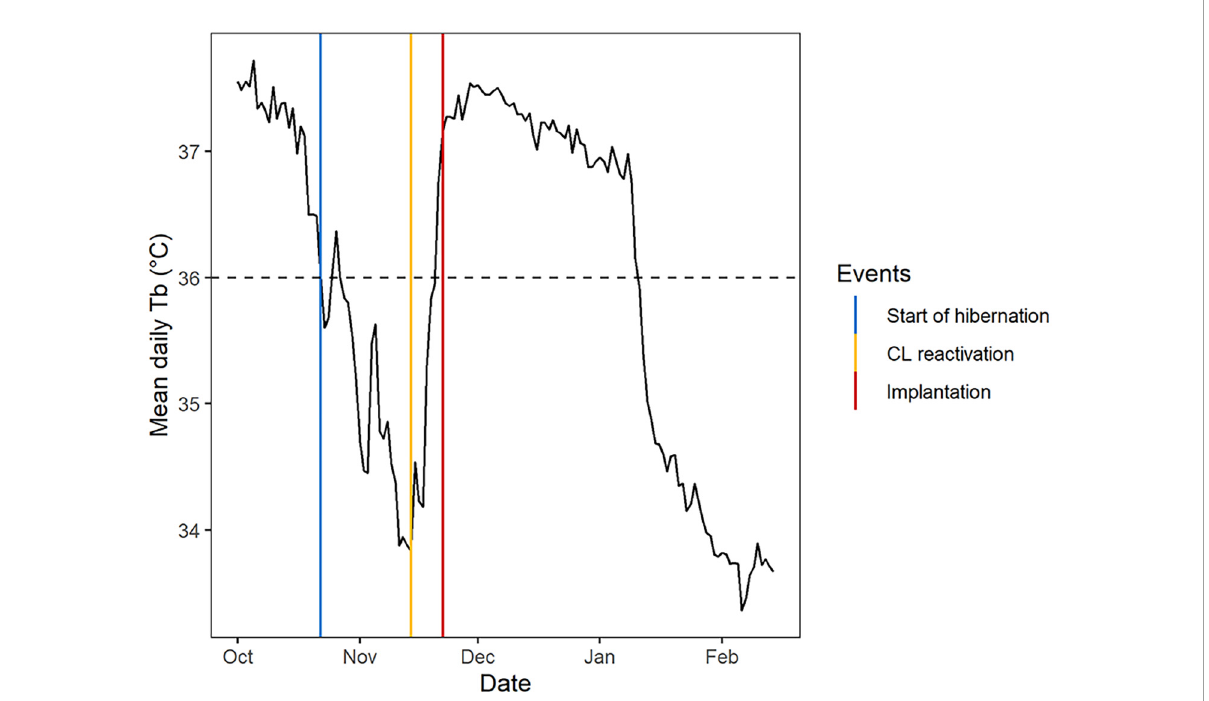
FIGURE1 Example of the mean daily body temperature (T b , ◦ C) profile of a pregnant adult female Scandinavian brown bear in the southern area from October to March, and associated hibernation and reproductive events. The start of hibernation (vertical blue line) was defined when mean daily T b decreased below 36 ◦ C for the first time in autumn (horizontal black dashed line). Corpus luteum (CL) reactivation (vertical yellow line) and embryo implantation (vertical red line) were defined, respectively, as a change point visually associated with the beginning and the end of the upward phase.